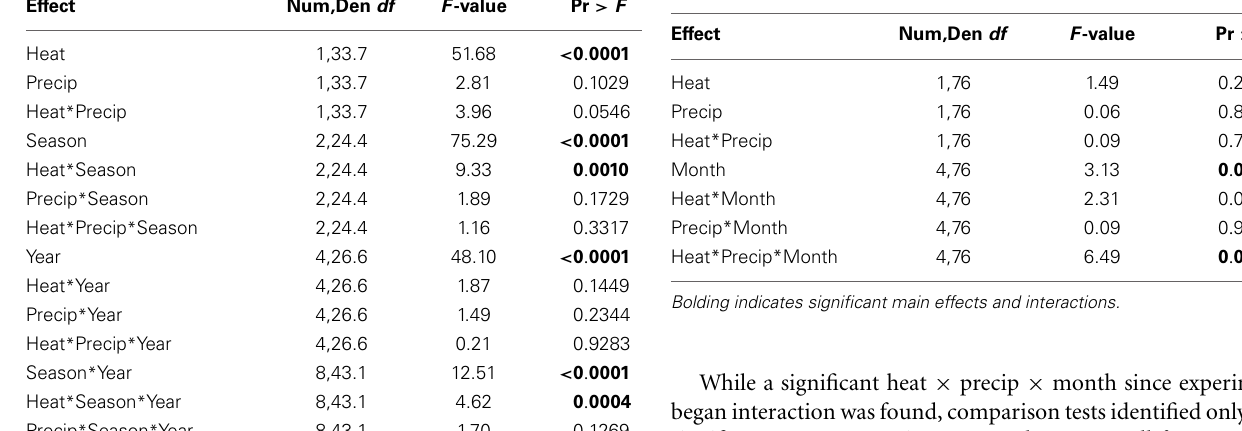
highest order significant interaction among the main effects of heat, season, and year is provided (see Table 2 for full statistical results). NS indicates the only harvest period where significant effects of heat were not observed.